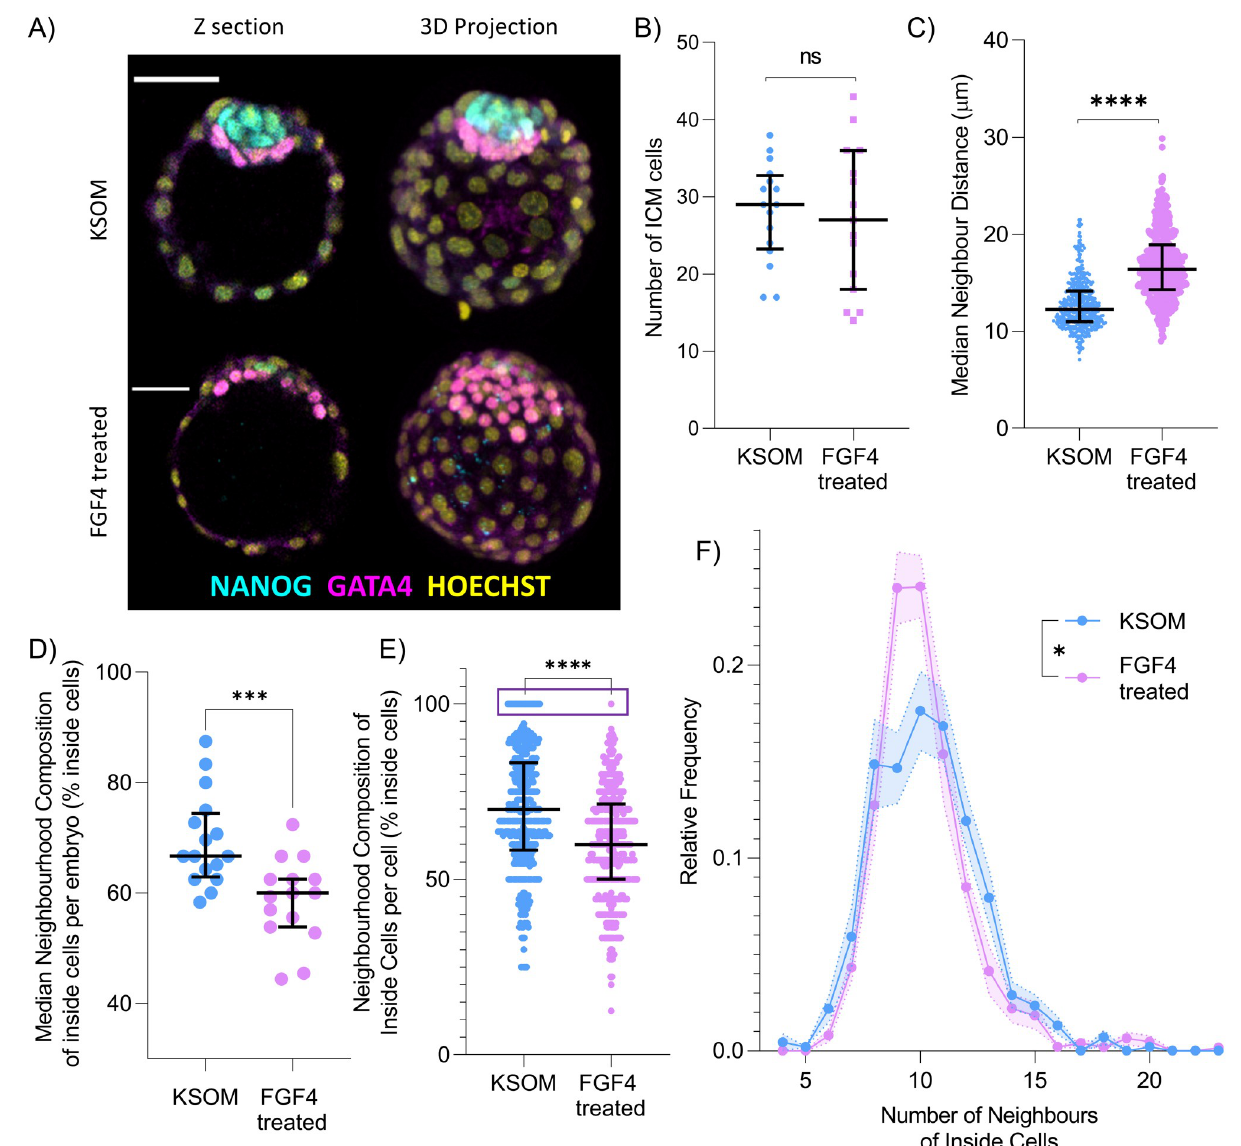
Fig 4. Comparison and quantification of morphological changes between embryos cultured in KSOM (control) and in KSOM+FGF4. (A) Expression of NANOG (Epi marker) and GATA4 (PrE marker) in the control group, compared with predominant expression of GATA4 in embryos cultured with FGF4. A more extended, flattened ICM is evident in embryos cultured with FGF4 when compared to embryos cultured in KSOM. Scale bar, 40 μ m. (B) Comparison of the number of ICM cells in KSOM-cultured embryos versus FGF4-treated embryos as classified by IVEN. (C) Comparison of the median neighbour distance between inside cells and their neighbours within the 2 treatment regimes. (D) The median value of the neighbourhood composition for inside cells per embryo, given as the percentage of neighbours that are also inside cells. (E) Neighbourhood composition of all inside cells analysed showing the reduction in the number of inside cells with 100% of neighbours also inside cells in the FGF4-treated group (purple box). (F) Average neighbourhood frequency distribution of inside cells with shaded regions indicative of the SEM, comparing culture conditions. Higher proportion of cells in FGF4 treatment conditions have lower numbers of neighbours when compared to KSOM- cultured embryos. Relative frequency refers to the normalised frequency (or probability) for each number of neighbours. Data underlying this figure can be found on the public GitHub repository https://github.com/jessforsyth/forsyth-et-al-2021. Epi, Epiblast; ICM, inner cell mass; IVEN, Internal Versus External Neighbourhood; PrE, primitive endoderm.